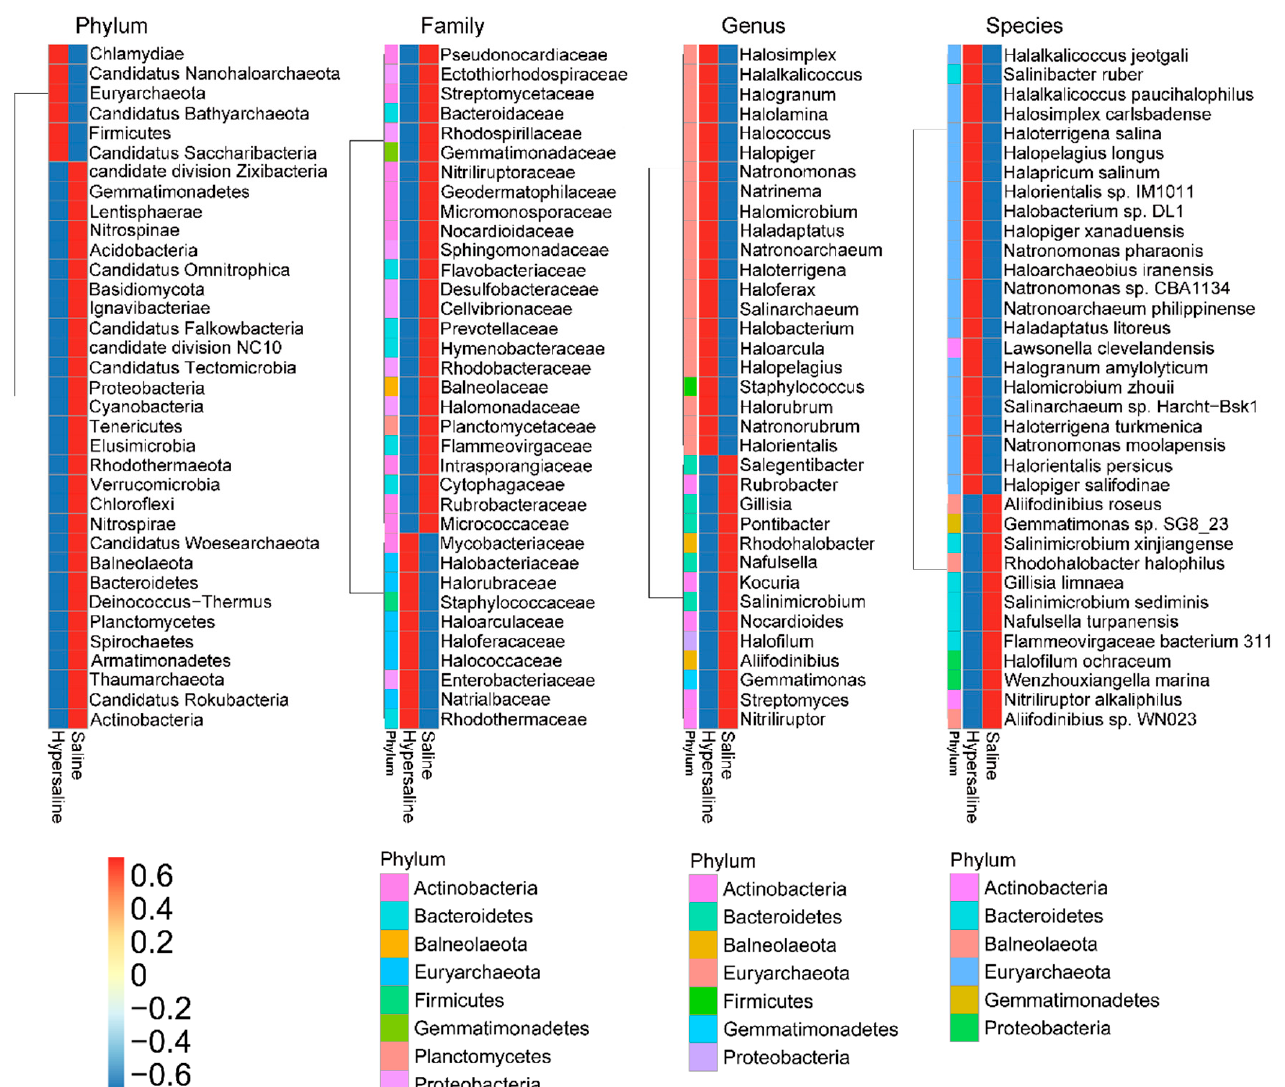
Figure 3. PCoA plot at the phylum ( A ) and genus ( B ) level illustrating the separation of microbial communities along axis 1 corresponding to the saline and hypersaline soils.